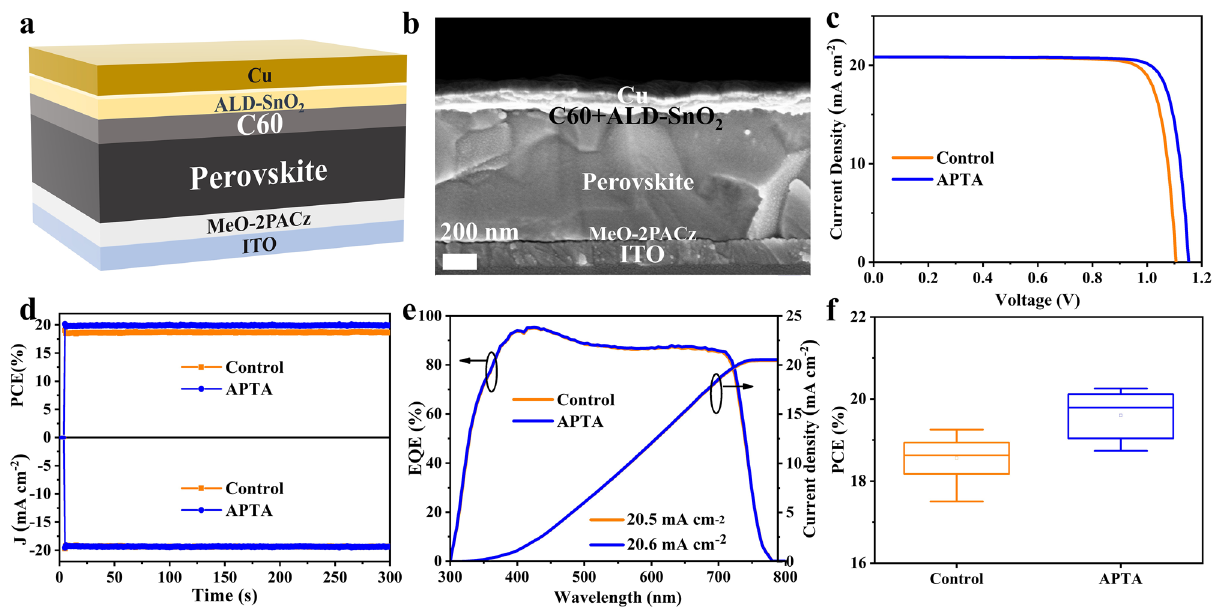
Fig. 3 a Device structure of the inverted WBG PSC. b Cross-sectional SEM image of a WBG PSC. c J–V curves of WBG devices without and with APTA incorporation. d Steady-state power output and current densities of the devices measured under constant bias voltages. e EQE and integrated J SC of the corresponding devices. f Statistical data of the PCE for WBG-based devices